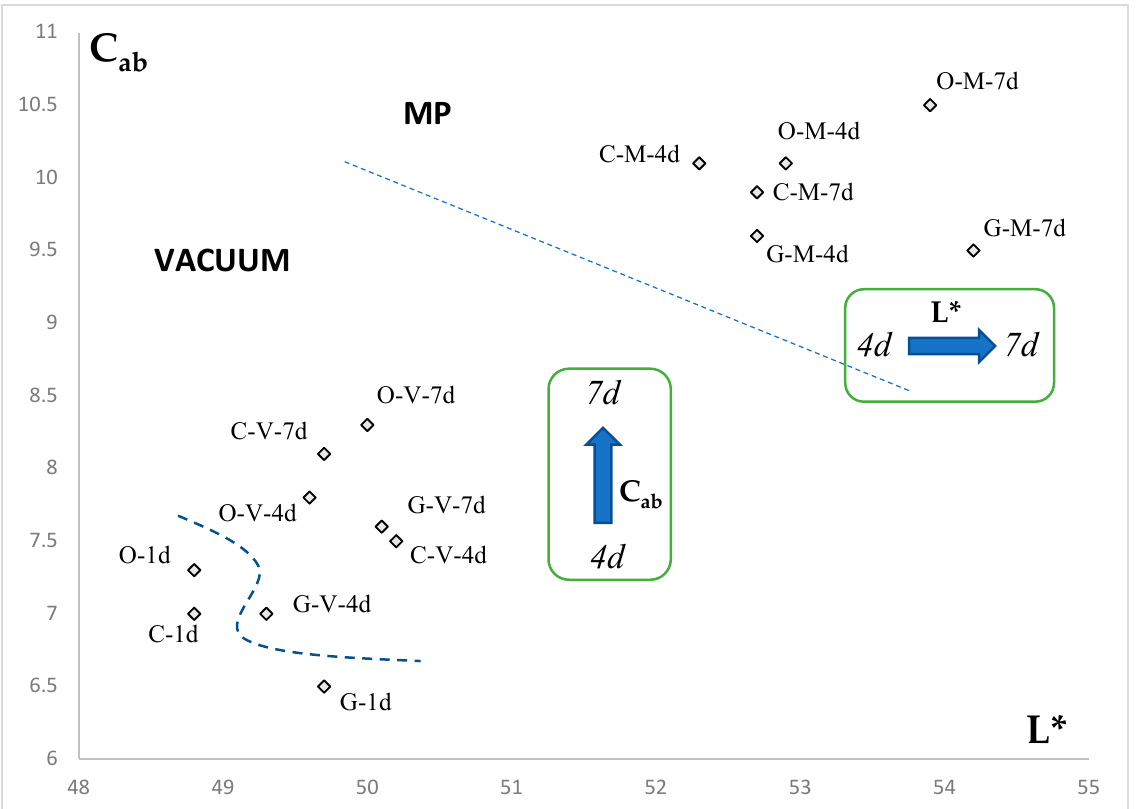
Figure 2. Representation of C ab vs. L* variables in function of the PDE, packaging type and storage time. C.—control batches; G.—garlic batches; O.—oil batches: V.—vacuum samples; M.—MAP samples; d.—day.